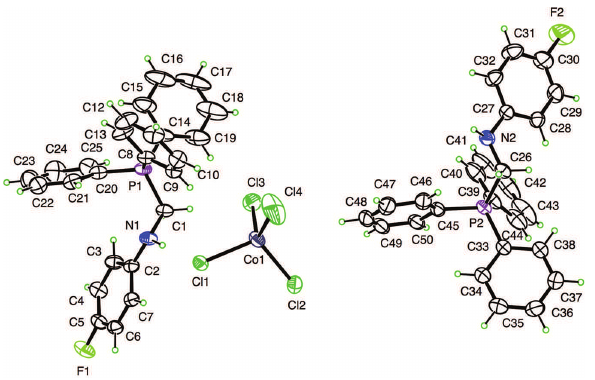
Table 1: Data collection and